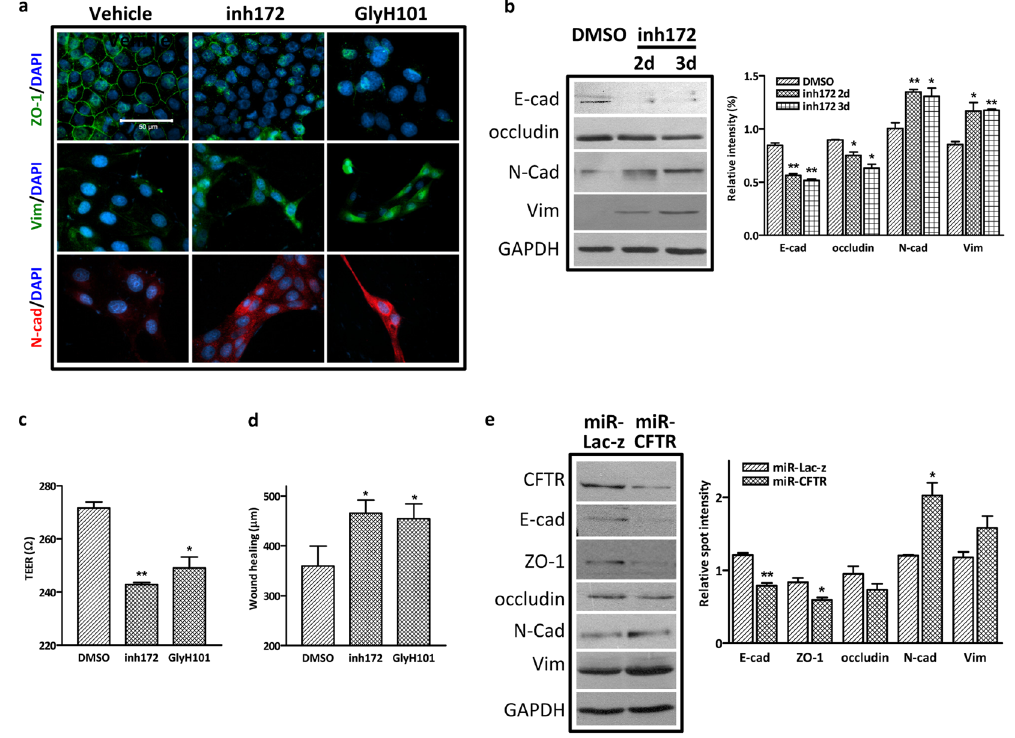
Figure 3. Suppression of CFTR induces EMT in MDCK cells. ( a ) Immunofluorescence staining showing decreased expression of ZO-1 and increased expression of N-cadherin and Vimentin in inh172 (10 µ M for 2 or 3 days)- or GlyH101- (2.5 µ M, 5 µ M and 10 µ M for 1 day) treated MDCK cells. Scale bar = 50 µ m; ( b ) Western blot analysis showing increased expression of N-cadherin and Vimentin, and decreased expression of E-cadherin and Occludin in 10 µ M inh172-treated MDCK cells. (Full-length blot is shown in Supplementary Figure S7e.) Quantification analysis is shown in the right panel, * p < 0.05, ** p < 0.01; ( c ) TER (Transepithelial resistance) is significantly lower in CFTR inhibitor-treated MDCK cells. * p < 0.05, ** p < 0.01, n = 3; ( d ) Wound healing assay showing enhanced cell migration at 24 hours with CFTR inhibitors treatment. At least 4 random fields per assay were counted and triplicate wells were set up for each sample. * p < 0.05; ( e ) Western blot showing decreased expression of ZO-1, E-cadherin and increased expression of N-cadherin and vimentin in CFTR knockdown cells. (Full-length blot is shown in Supplementary Figure S7f.) Quantification is shown in the right panel, * p < 0.05; ** p <